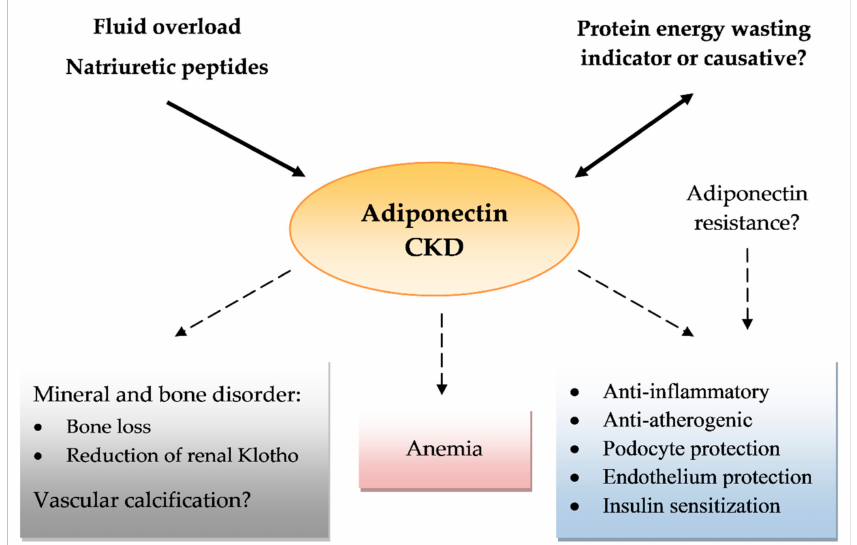
Figure 1. E ff ects of adiponectin in chronic kidney disease (CKD). Arrows pointing at adiponectin show a role of protein energy wasting, fluid overload, and natriuretic peptides in increasing serum adiponectin levels as a possible confounding factor. A number of question marks reflect the uncertain e ff ects or conflicting results of